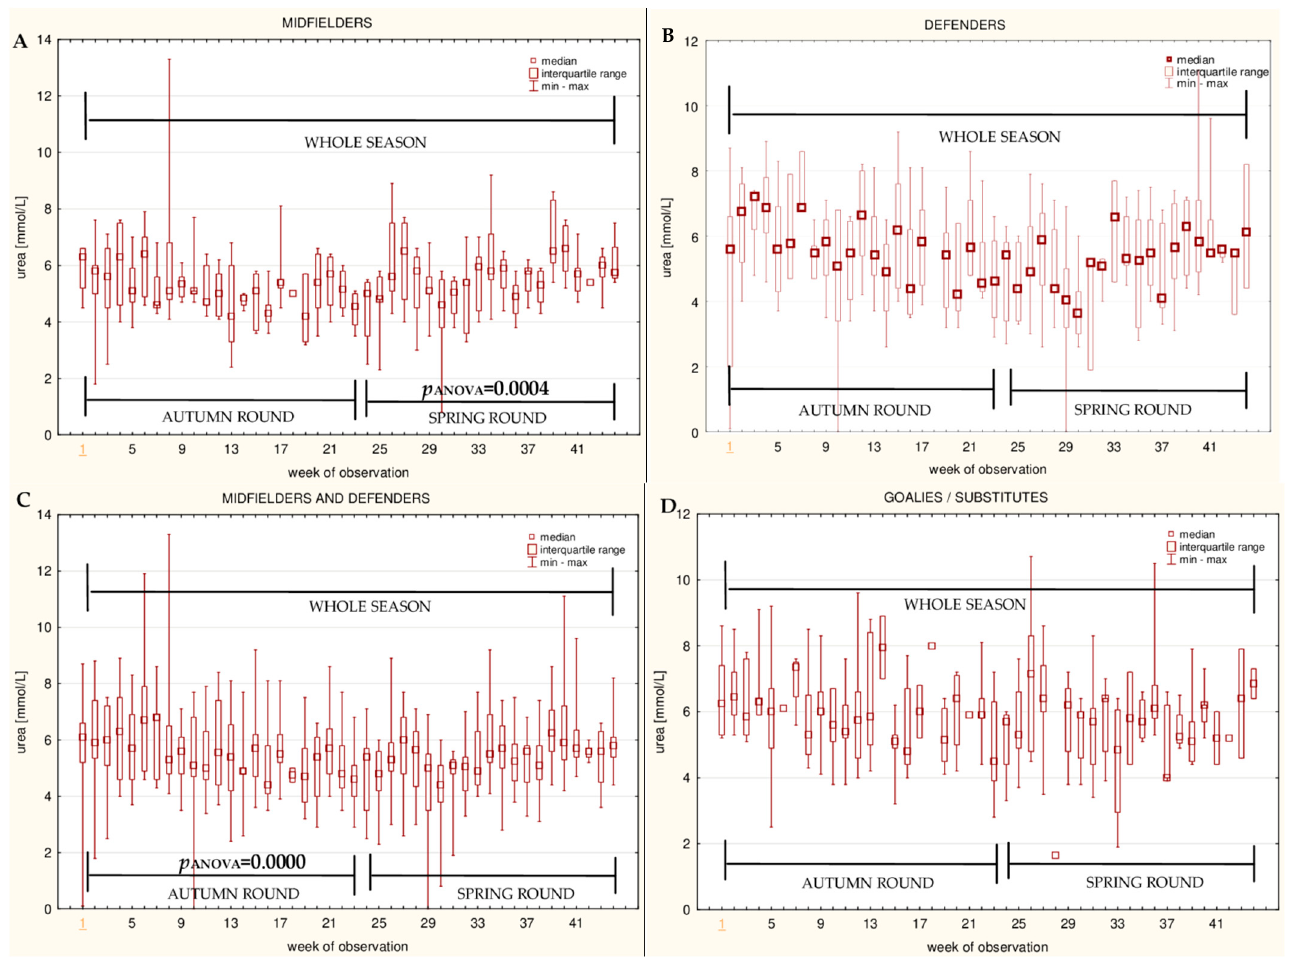
Figure 7. Median urea (U) levels in: ( A ) The midfielder, ( B ) defender, ( C ) midfielder / defender and ( D ) goalie / substitute subgroups over the course of the soccer match